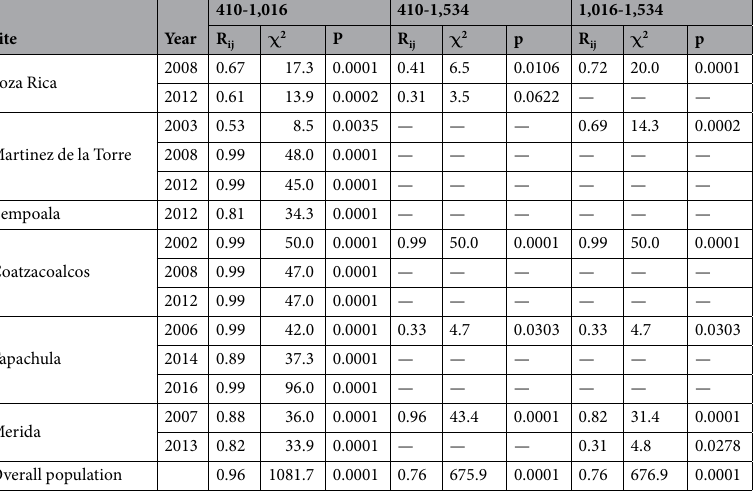
Table 2. Linkage disequilibrium coefficients (R ij ), χ 2 and associated probabilities between loci 410-1,016, 410- 1,534 and